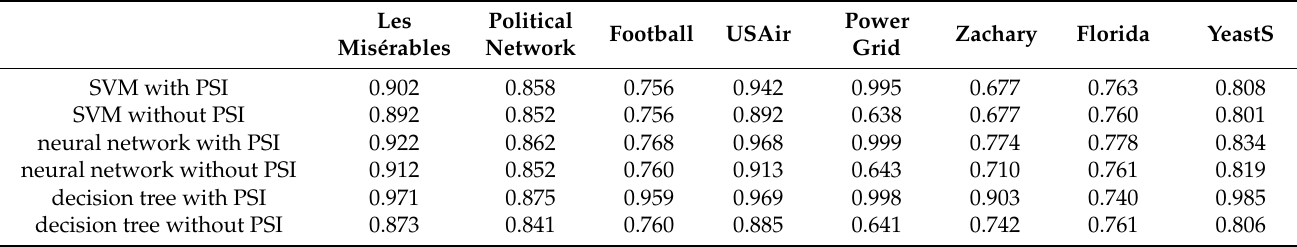
Table 11. Results of support vector machine (SVM), neural network and decision